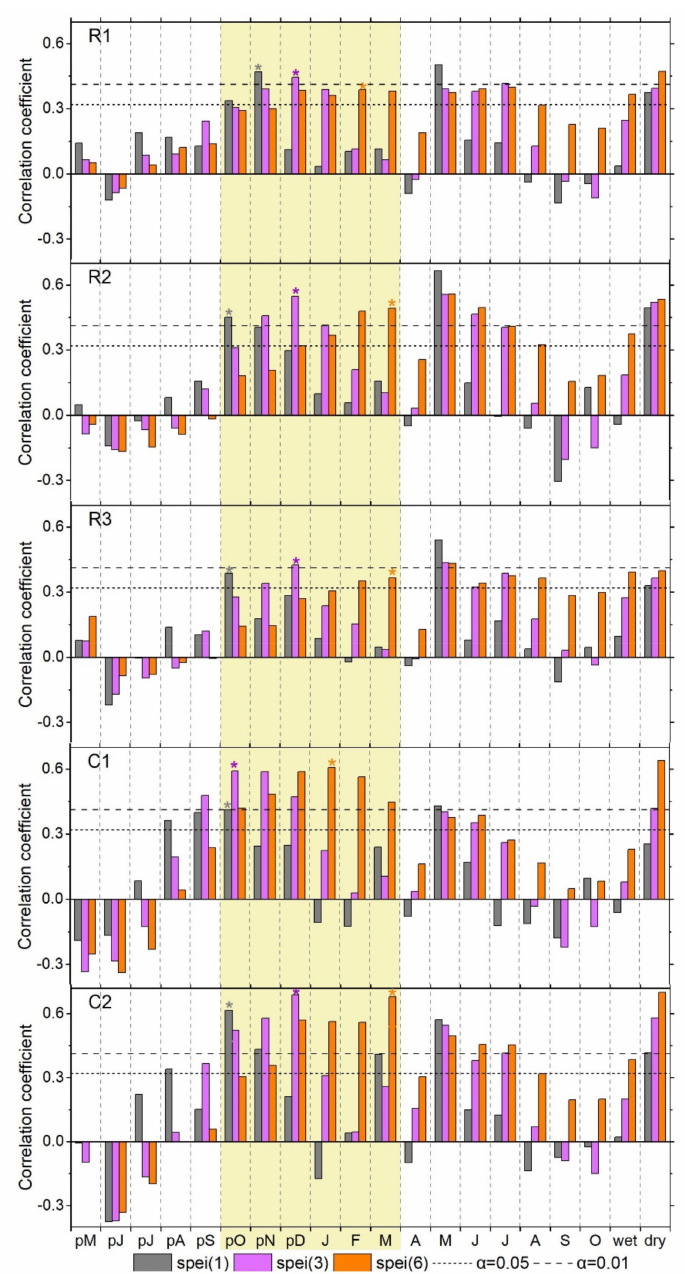
Figure 4. Correlation coe ffi cients between the standardized precipitation evapotranspiration index (SPEI)andtreeringwidthchronologies. Thenumberinthebracketsrepresentsthetimescaleofthemonth of SPEI. The light-yellow area covers the six month period after the previous October. The star marks the largest value corresponding to its columns with the same color inside the light-yellow